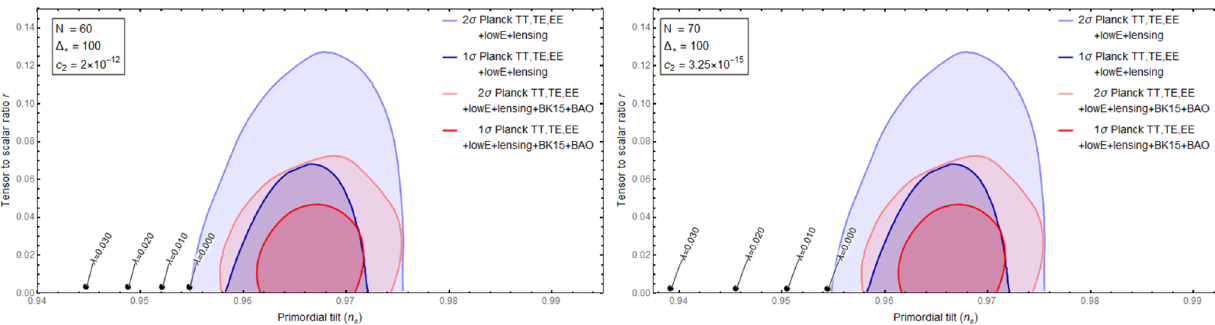
Fig. 7 We compare the theoretical predictions in the ( r − n s ) plane for different values of λ using (cid:23) (cid:25) = 10 , c 2 = 10 − 11 , N = 60 (upper- left panel); (cid:23) (cid:25) = 100 , c 2 = 10 − 15 , N = 60 (upper-right panel);